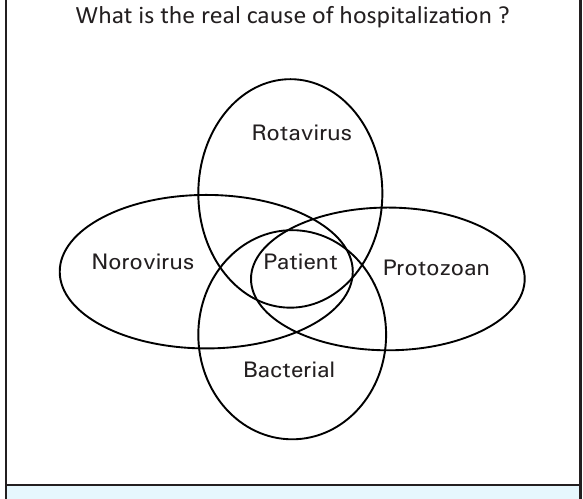
Figure 1. Cause of